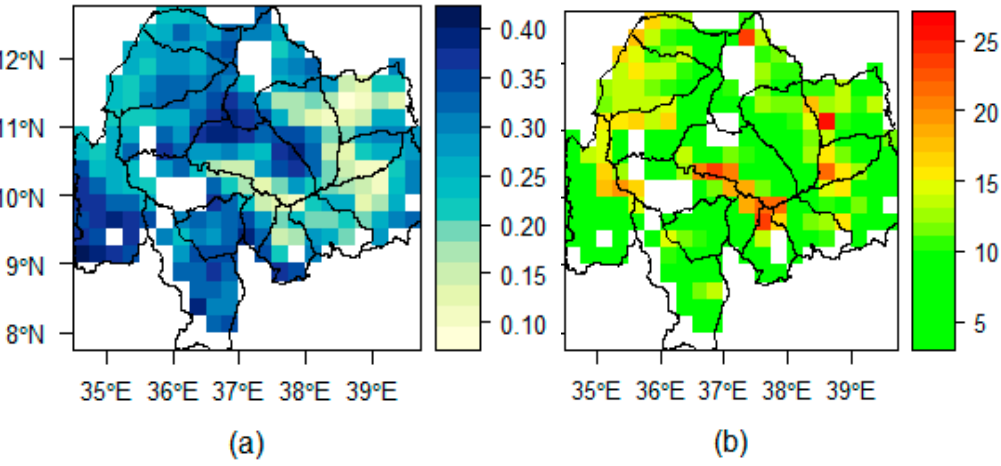
Figure 3. Spatial patterns of ( a ) mean autumn (September to November average) soil moisture (ASM) (m 3 /m 3 ) and ( b ) coefficient of variation (CV, %) over the UBNB in Ethiopia for the period of 1992 to 2017. Note that the white regions (open pixels) show the pixels with missing values in the ESA CCI soil moisture dataset.